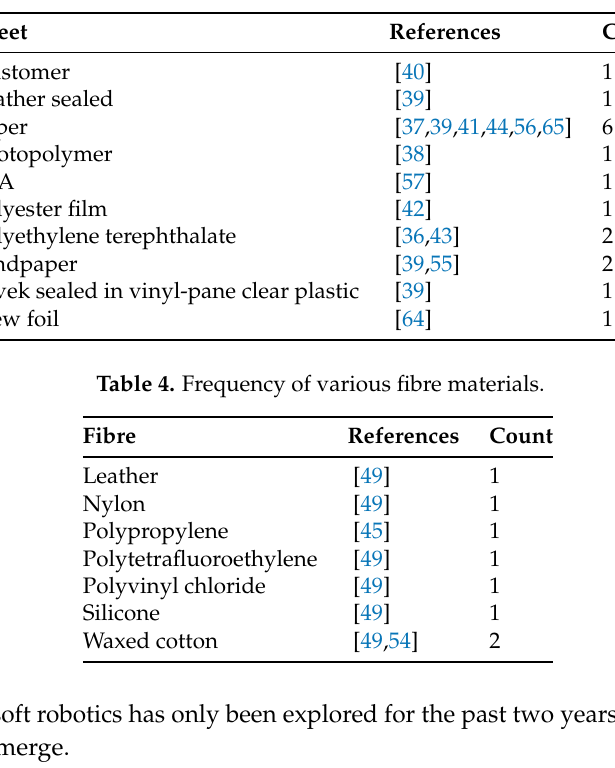
Table 3. Frequency of various sheet materials.